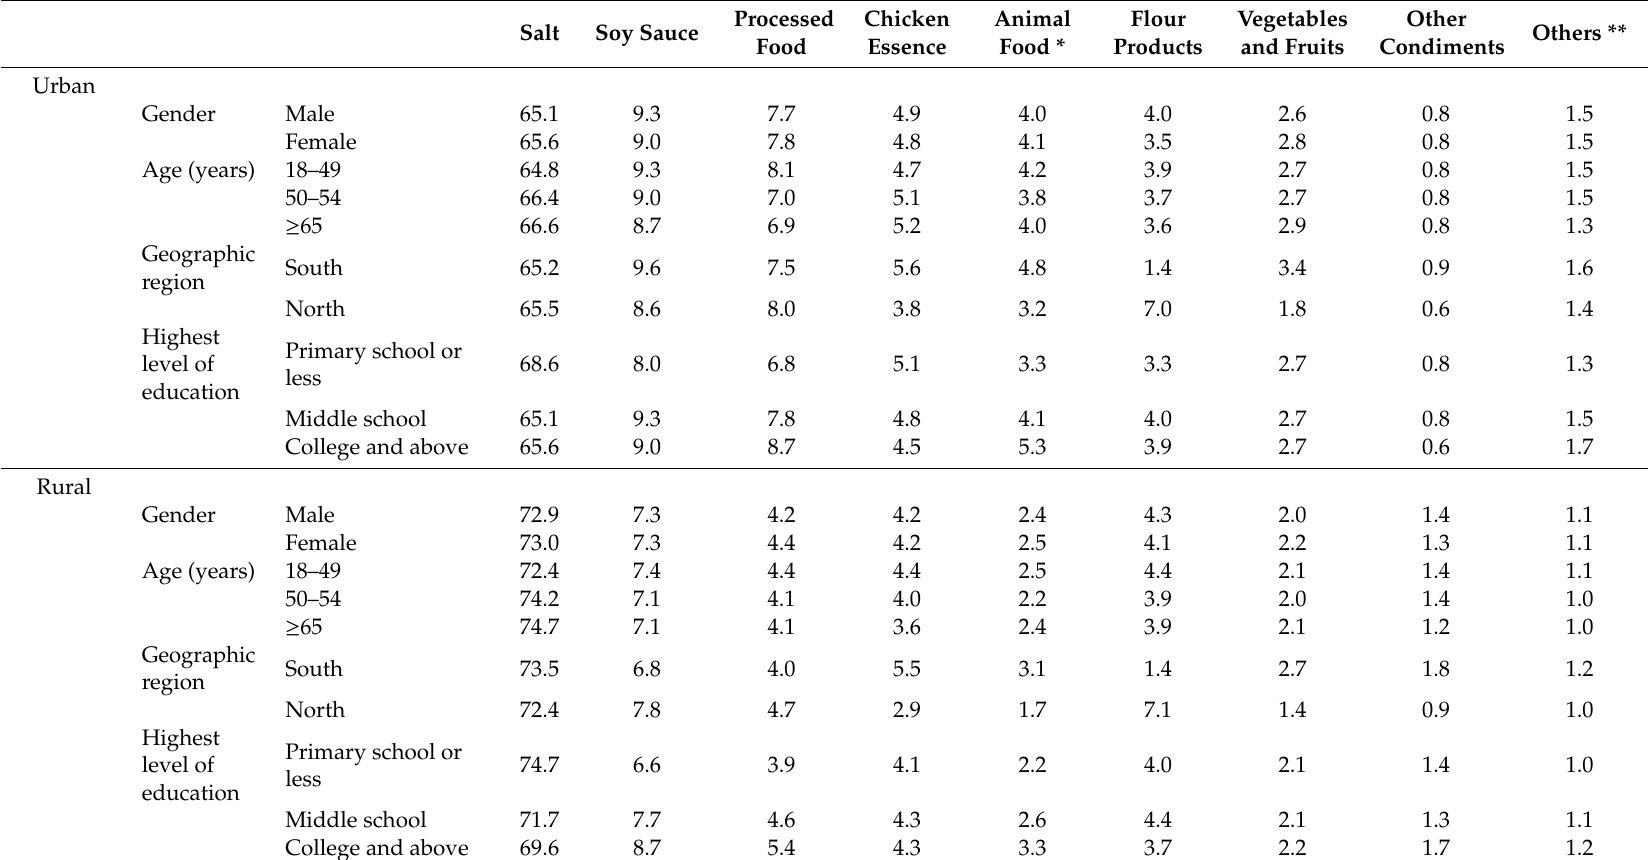
Table 3. Proportion contribution of the main food groups to total dietary sodium (%). Salt Soy Sauce